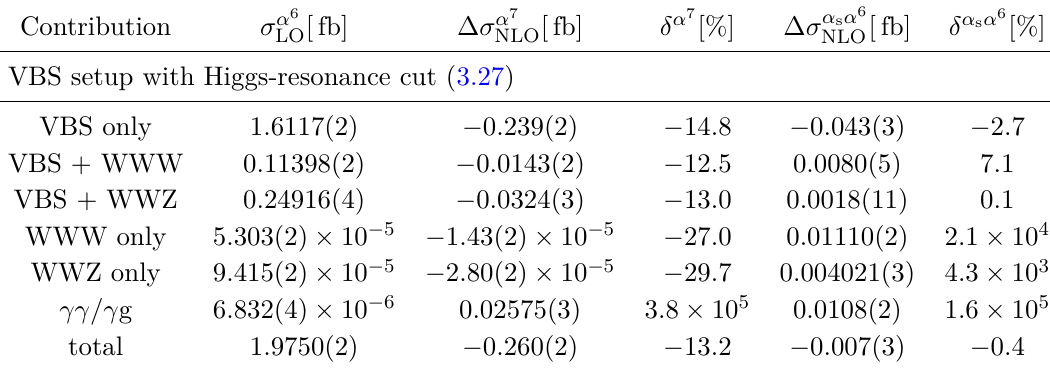
(cid:0) (cid:1) α 6 and NLO cross section of O